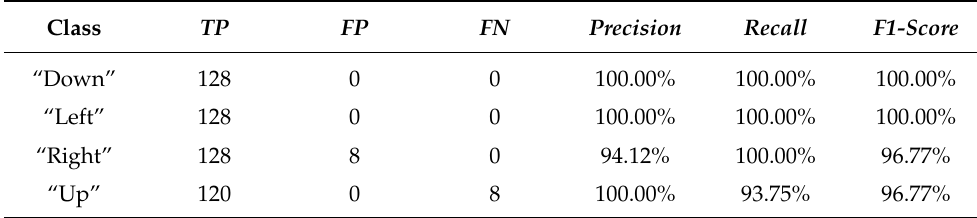
Table 6. Performance metrics of the network trained and validated with data in Figure 6c.